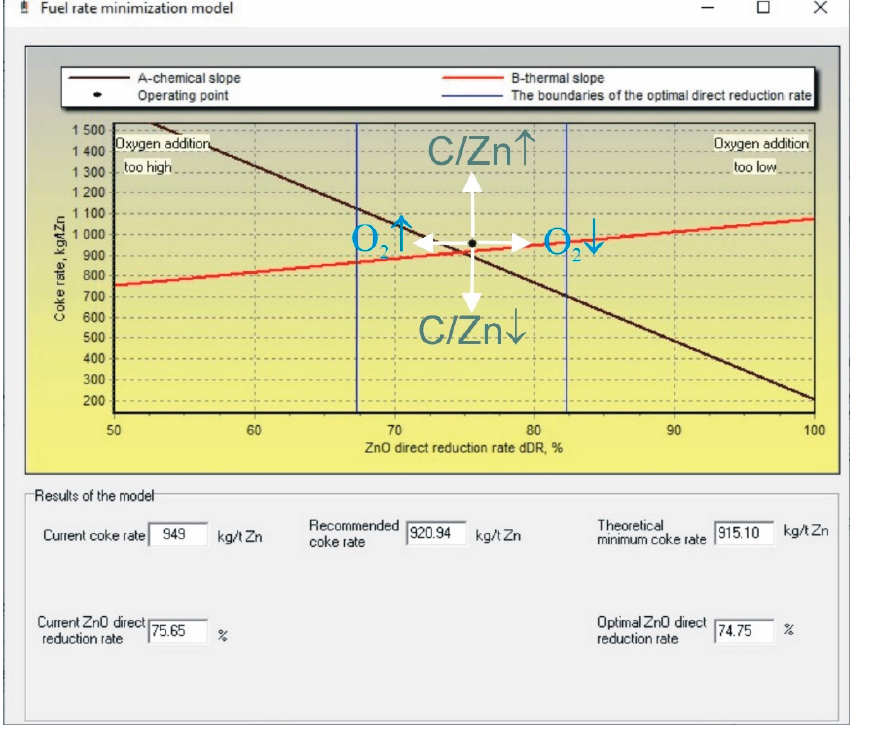
Figure 8. View of the fuel rate minimization model working on real data.